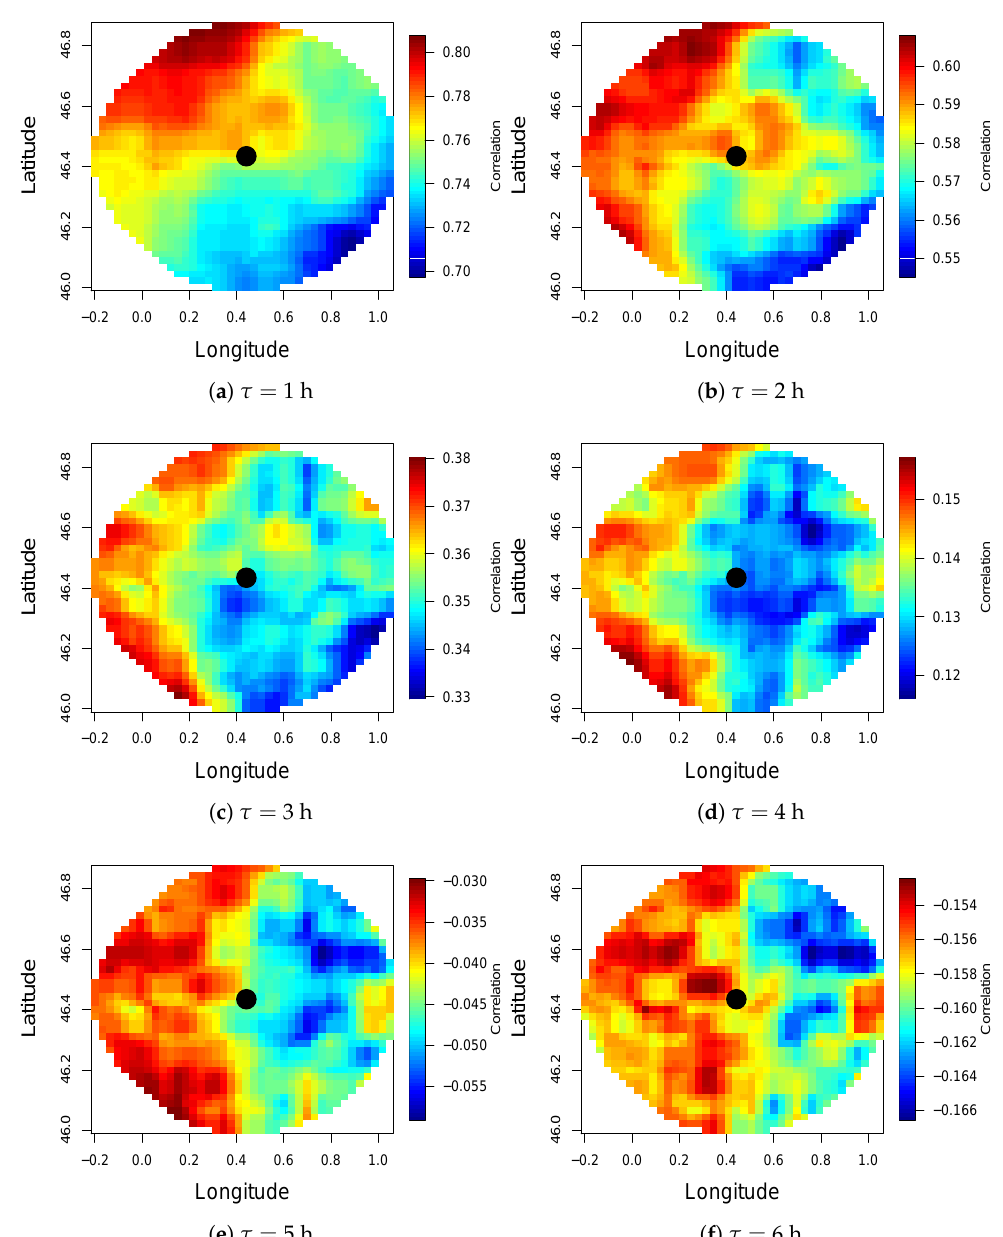
Figure 6. Values of the association coefficient between on-site measurement with time offsets and satellite image estimates for a power plant in the West of the covered region. The PV plant is represented by the black dot, τ represents the time